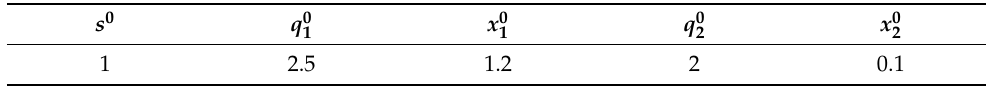
Table 5. The initial conditions used in Example